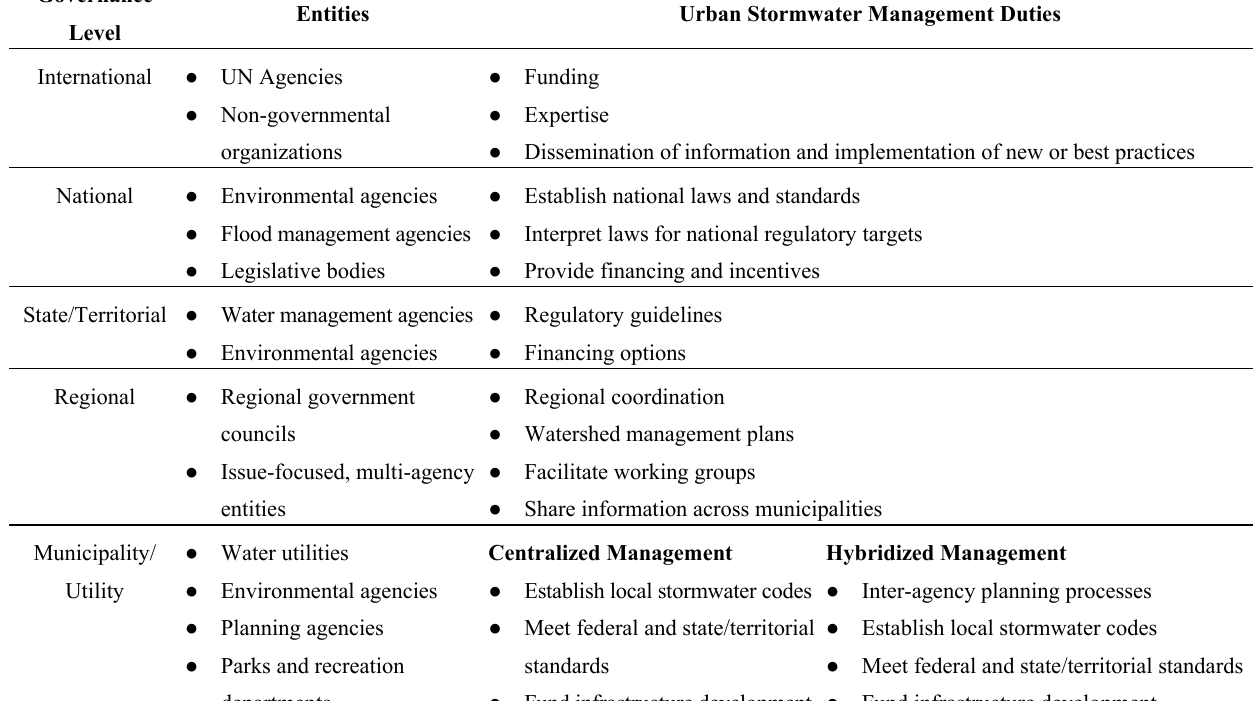
Table 3. Entities and associated responsibilities by scale of governance for centralized and hybrid stormwater system